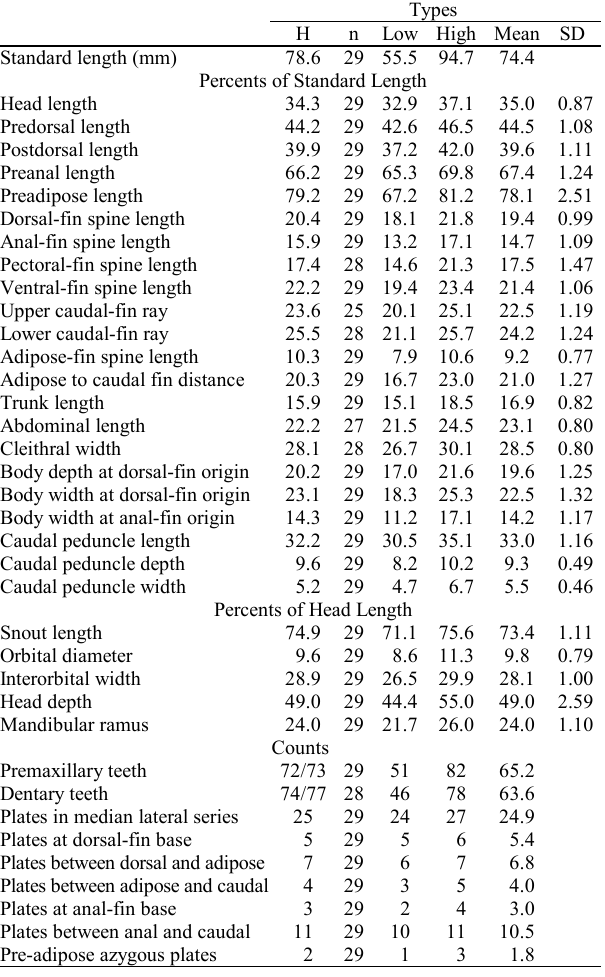
Table 1. Morphometric and meristic data of Pareiorhaphis nasuta . Values are given as percent of standard length or head length. SD = standard deviation, n = number of specimens, H =